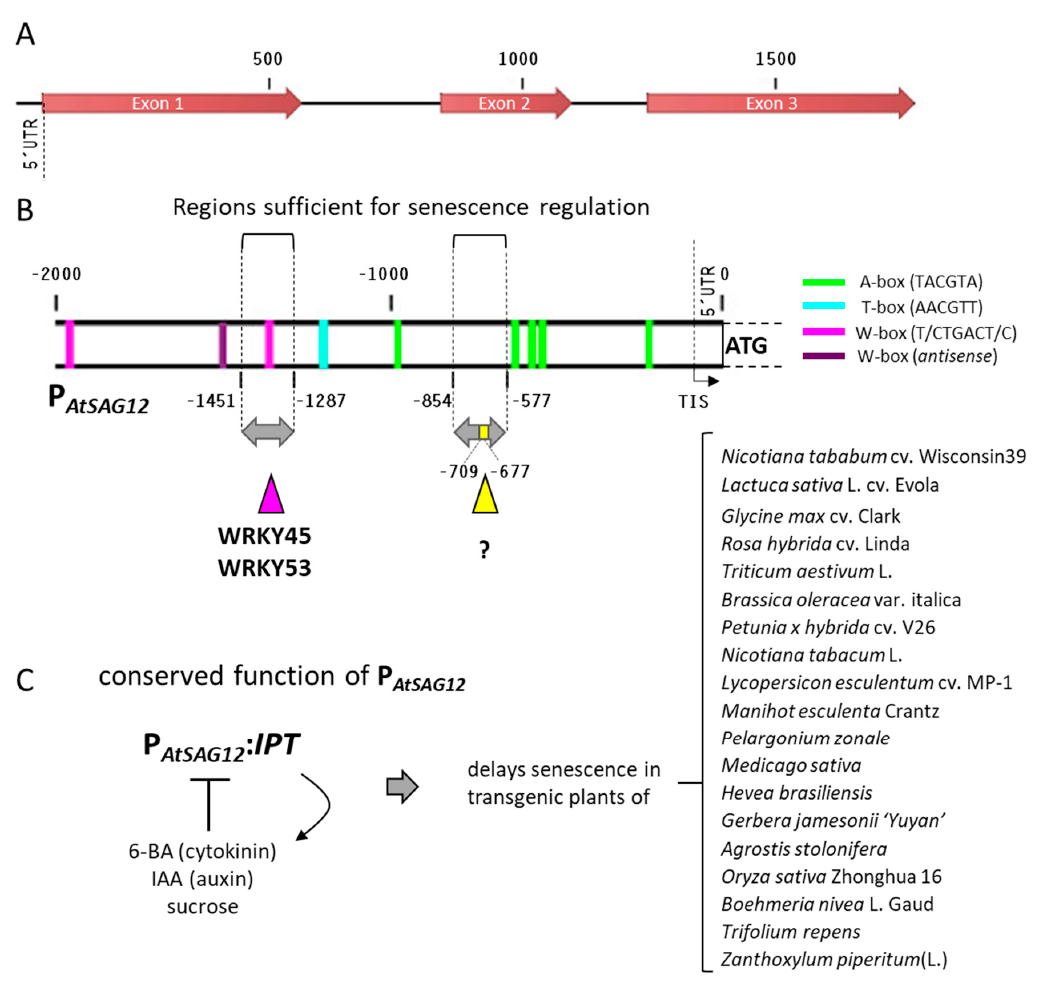
Figure 1. Gene and promoter structure of AtSAG12 . ( A ) Exon (red arrows) and intron (black line) structure of AtSAG12 (AT5G45890.1) and ( B ) 2000 bp region adjacent to the ATG start codon, including the 5 (cid:48) UTR, annotated for the presence of W-boxes (T/C TGAC T/C), A-boxes (TACGTA), T-boxes (AACGTT), C-boxes (GACGTA), and G-boxes (CACGTA). W-boxes in sense (Pink), W-boxes in anti-sense (Purple), A-boxes (Green), T-boxes (Cyan). The two regions characterized by Noh and Amasino [14] are indicated by the grey arrows. WRKY45 and WRKY53 were shown to bind to the W-box in the region − 1451 to –1287 relative to the start codon (pink triangle) [15,16], which is equivalent to the enhancer region ( − 1345 to − 1181 relative to the TIS) [14], whereas in the 32 bp region indicated in yellow ( − 709 to − 677 relative to the start codon) binding of unknown protein(s) was observed [14]. ( C ) The promoter region of AtSAG12 was used in a transgenic approach to drive the isopentenyl transferase gene ( IPT ), which leads to an increase production of cytokinins, which then inhibits the SAG12 promoter activity. This autoregulatory feedback loop delays senescence in many different species indicating a conservation of all functional components. TIS (transcription initiation site), ATG (start codon), 5 (cid:48) UTR (5 (cid:48) untranslated